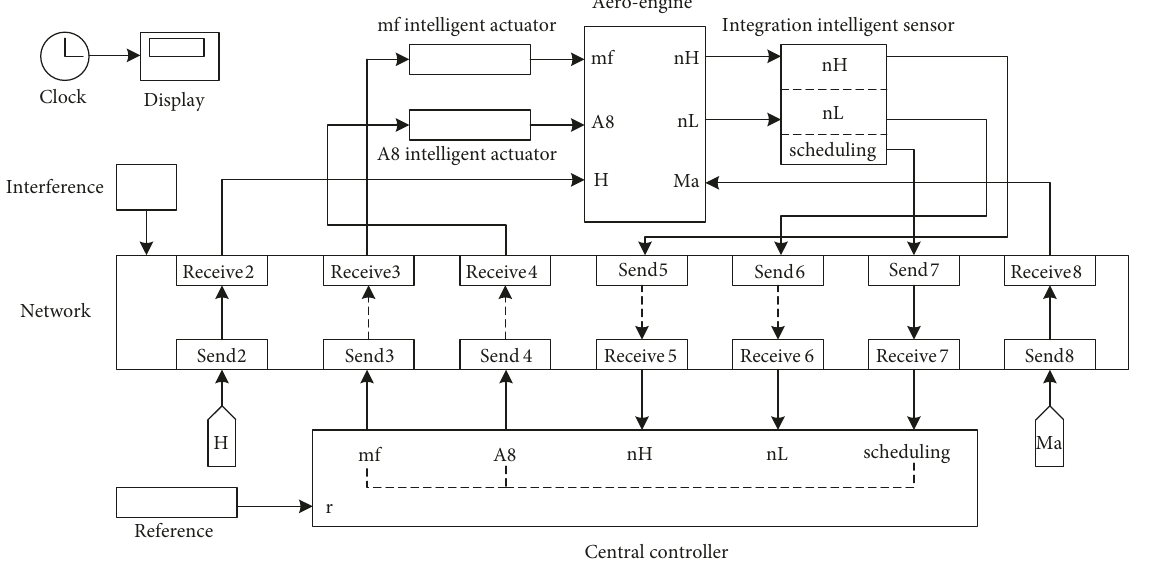
Figure 2: Simplified block model of the TrueTime simulation for an aeroengine networked control